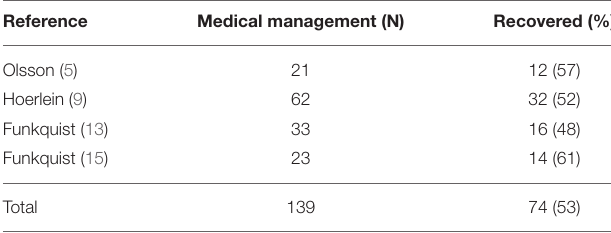
TABLE 2 | Synthesis of outcome data from dogs managed medically for intervertebral disc herniation and published before